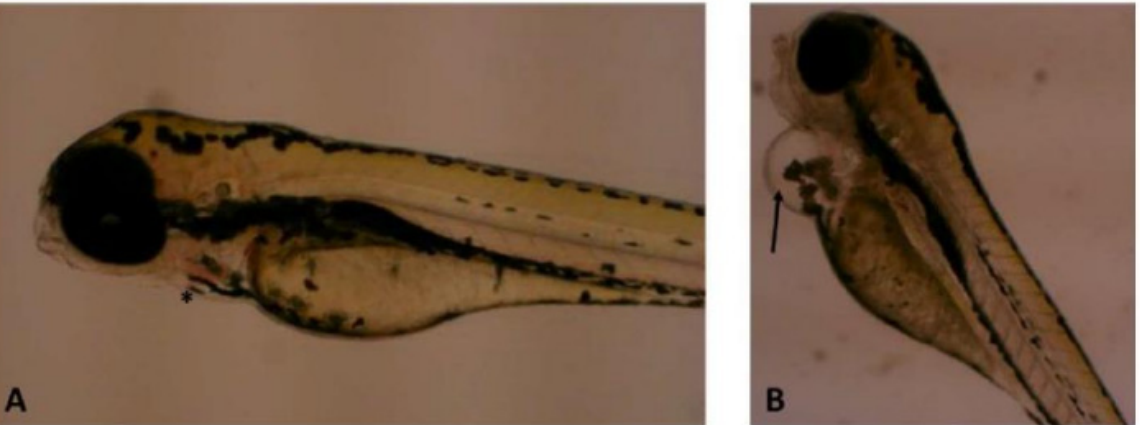
Figure 3. Embryos after 96 h. ( A ) Animal of the negative control group, with normal cardiac development (*) and ( B ) animal exposed to treatment with microcyclamide (50 µ g mL − 1 ), with edema in the pericardium ( → ).